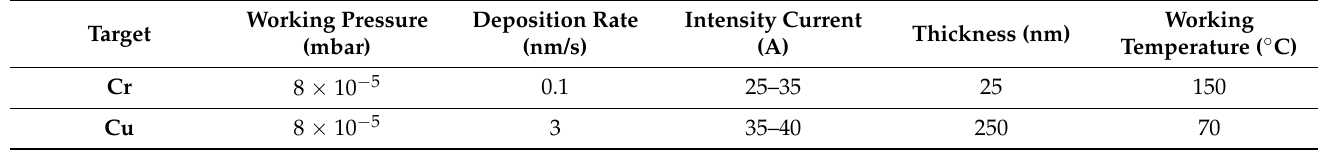
Table 1. Parameters to prepare the